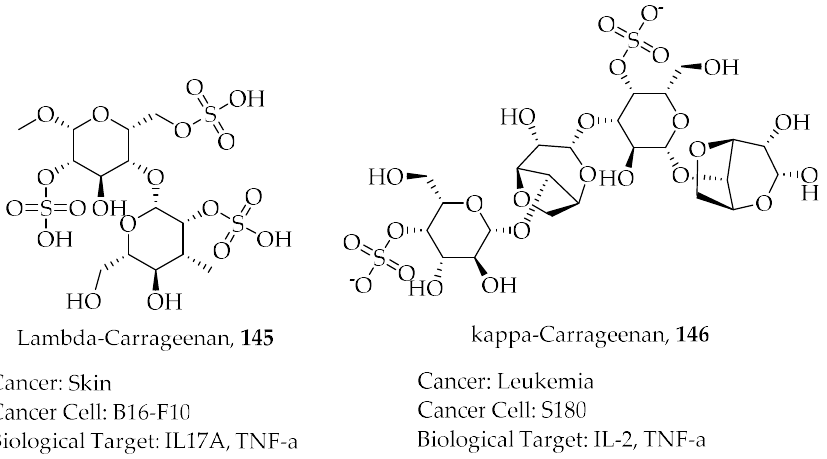
Figure 33. Structures of Sulphated galactopyranosyl Lambda-Carrageenan and Kappa-Carrageenan with a summary of their biological activity towards selected cancer targets.